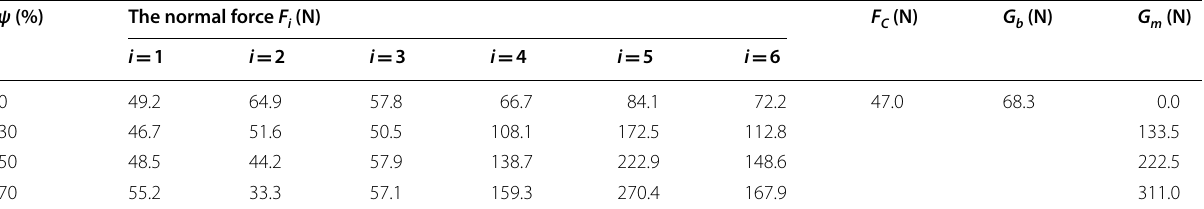
Table 4 Roller normal force in the case of different ψ